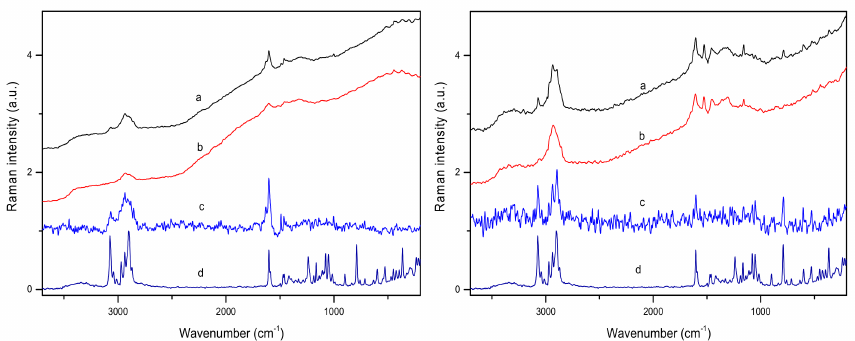
Figure 4. Raman spectra of poplar bark ( left ) and leaves ( right ) containing the maximal (a) and minimal (b) contents of salicylates, difference spectra (c), and the spectrum of salicin (d).